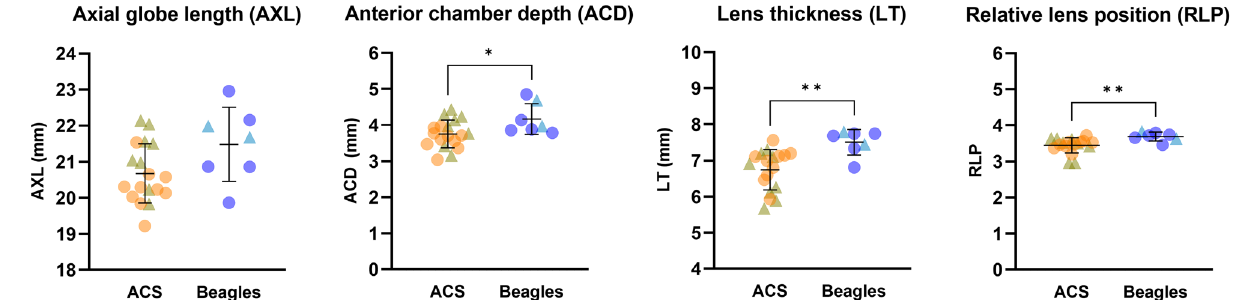
Figure 2. The ACSs have significantly more crowded anterior ocular segment structures. While the overall globe size was not different between the two breeds, the anterior chamber was significantly shallower in ACS versus Beagles. Although the ACS have significantly thinner lenses, the lenses were more anteriorly located in ACS versus Beagles. An unpaired t -test was performed (n = 18 ACS and 7 Beagles; * = p value < 0.05; ** = P value < 0.01). The line and error bars indicate mean values and standard deviations. The circles and triangles indicate females and males, statistically significant ( p = 0.0452). There was no statistical difference in IOP between males and females for both ACSs and Beagles. A-scan ocular ultrasonography was performed in 18 ACSs (mean age, 10.7 years; 8 neutered males and 10 spayed females) and 7 Beagles. While the axial globe length (AXL) was not statistically different between the two breeds (20.67 ± 0.81 and 21.48 ± 1.02 mm for ACS and Beagle, respectively), there were statistically significant differences in anterior chamber depth (ACD), lens thickness (LT) and relative lens position (RLP) between the two breeds (Fig. 2). The anterior chamber was shallower in ACS (3.75 ± 0.39 mm) versus the Beagle (ACD: 4.17 ± 0.43 mm; p = 0.0278). The lens was thinner in ACS (LT: 6.74 ± 0.56 mm) compared to the Beagle (7.50 ± 0.35 mm; p = 0.0028) and was more anteriorly located in ACS (RLP: 3.44 ± 0.21 and 3.69 ± 0.12 for ACS and Beagle, respectively; p = 0.0039). Within the ACSs, AXL was statistically greater in males versus females (AXL: 21.17 ± 0.82 mm for males and 20.28 ± 0.60 mm for females; p = 0.0175) while the other A-scan ocular biometry parameters did not significantly differ between sexes. In Beagles, no statistical differences were identified between males and females for all A-scan ocular biometry parameters. Ultrasound biomicroscopy (UBM) was performed in 24 ACS and 7 Beagle dogs. One Beagle dog was excluded from image analysis due to the presence of ciliary cysts in the dorsotemporal posterior chamber OU where the probe was applied in order to avoid their possibility of distorting ciliary cleft and iris configurations 13 . Regard- ing ciliary cleft-related parameters, most were significantly smaller in ACS versus Beagle dogs (CCWE (ciliary cleft width at the entrance), 0.22 ± 0.04 mm for ACS and 0.36 ± 0.09 mm for Beagle ( p < 0.0001); CCWM (ciliary cleft width at the middle), 0.23 ± 0.04 mm for ACS and 0.34 ± 0.07 mm for Beagle ( p < 0.0001); CCA (ciliary cleft area), 0.39 ± 0.09 mm for ACS and 0.75 ± 0.30 mm for Beagle ( p < 0.0001); Fig. 3). The exception was ciliary cleft length (CCL), which was 1.69 ± 0.27 mm for ACS and 1.25 ± 0.20 mm for Beagle ( p = 0.0008). Regarding the iris-related UBM parameters, iris contact with the anterior lens capsule or iridolenticular contact (ILC) was significantly greater in the ACS (1.79 ± 0.43 mm) versus Beagle (0.75 ± 0.30 mm; p < 0.0001). In addition, the iris, as measured by iris deflection (ID), in the ACS (− 0.55 ± 0.21 mm) was more concave (pos- teriorly deflected) compared to the Beagle (− 0.34 ± 0.12 mm; p = 0.0271) (Fig. 4). For all UBM parameters, there were no statistical differences between males and females for both ACS and Beagles.